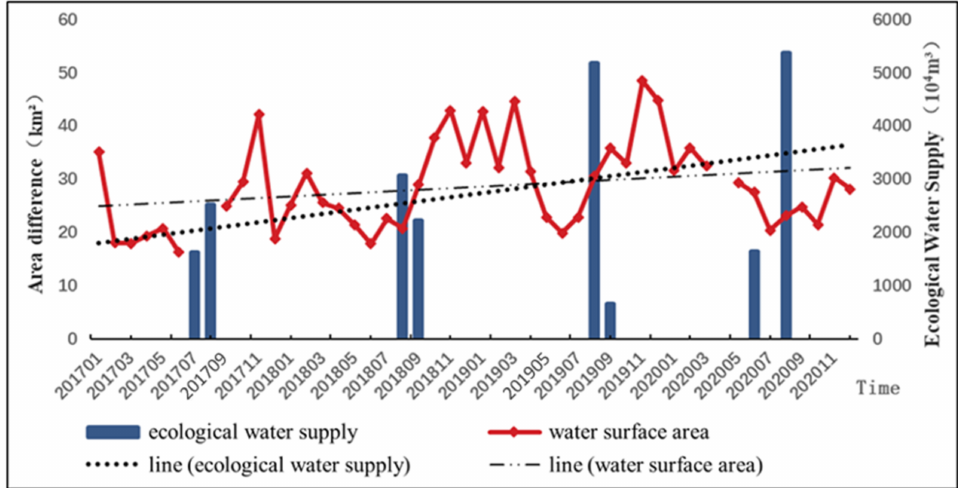
Figure 4. Plot of the monthly values of lake water surface area and ecological water supply quantities from 2017 to